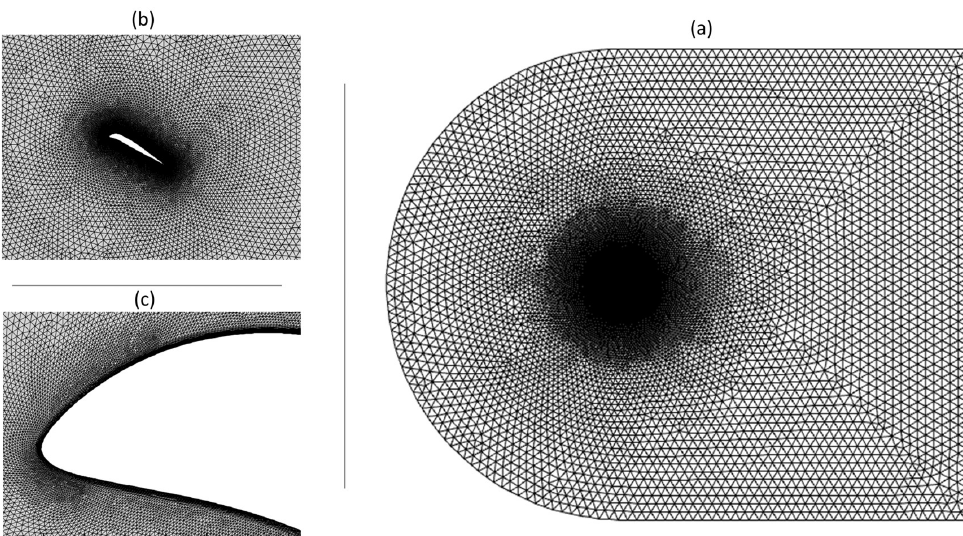
Figure 3. Computational domain with ( a ) hybrid mesh, ( b ) structured mesh around the airfoil, and ( c ) DMLE UAS-S45 airfoil mesh.